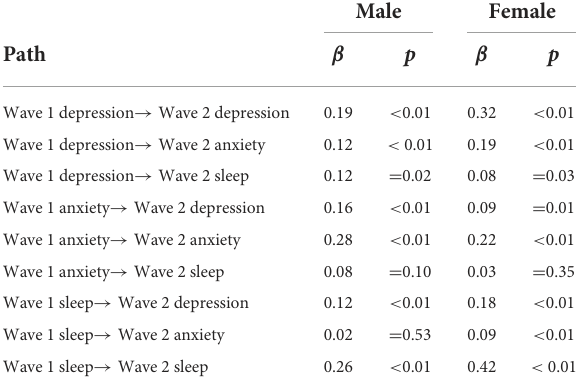
TABLE 2 Pairwise parameter